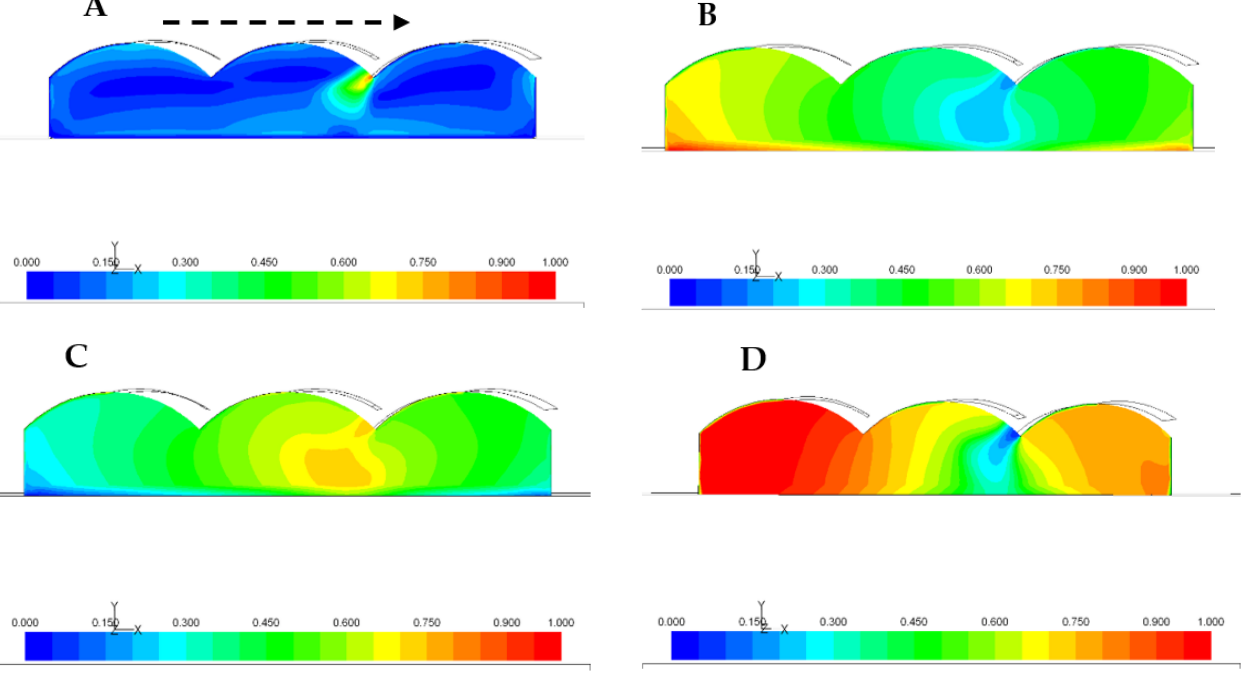
Figure 1. Spatial distribution of ( A ) wind speeds (m s − 1 ), ( B ) temperatures (° K), ( C ) relative humidity (%), and ( D ) fraction of transpired water (gr h − 1 m − 2 ).